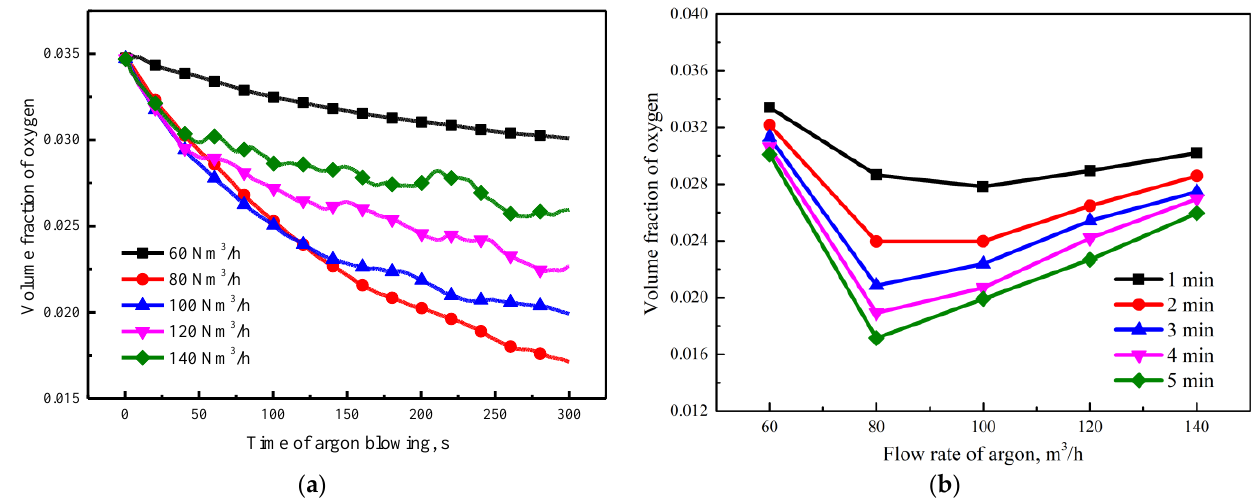
10 of 13 10 of 13